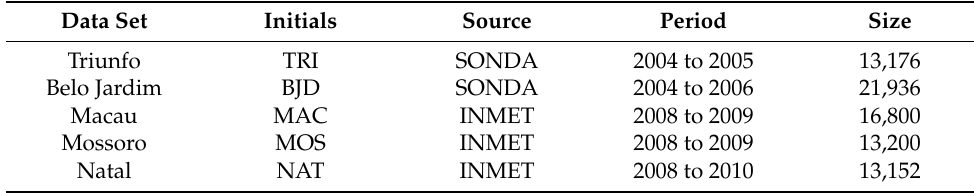
Table 1. Wind Speed Series.